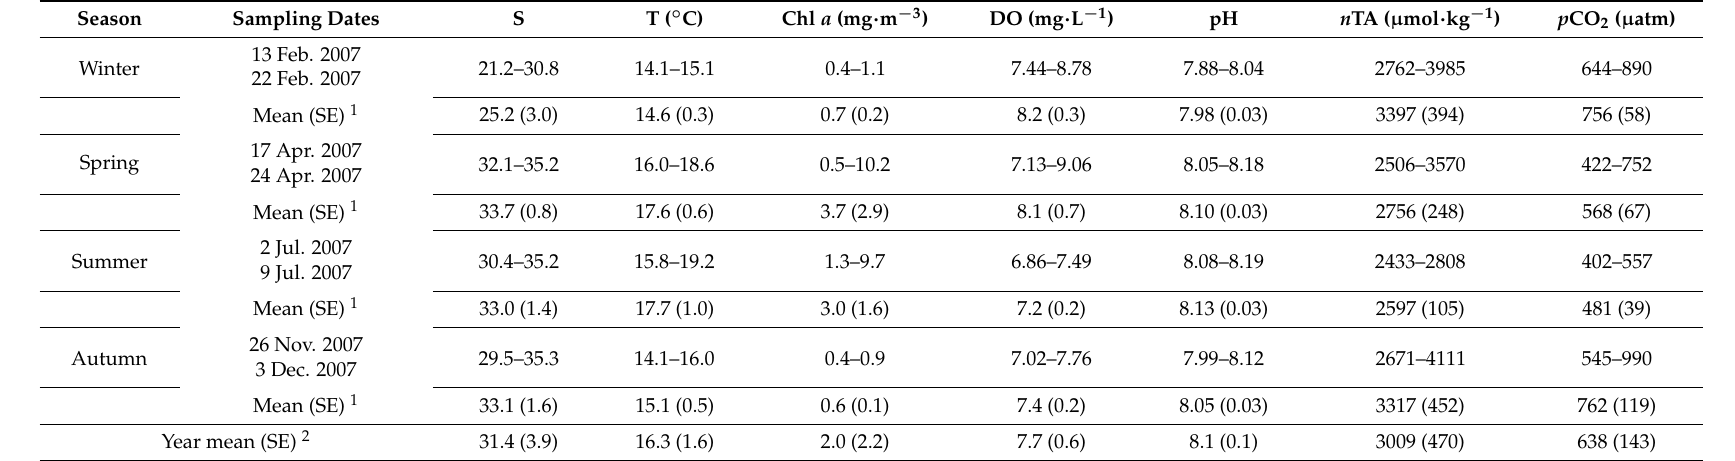
Table 2. Range of physical-chemical and biological parameters in each sampling period during year 2007 in the Tagus estuary fixed